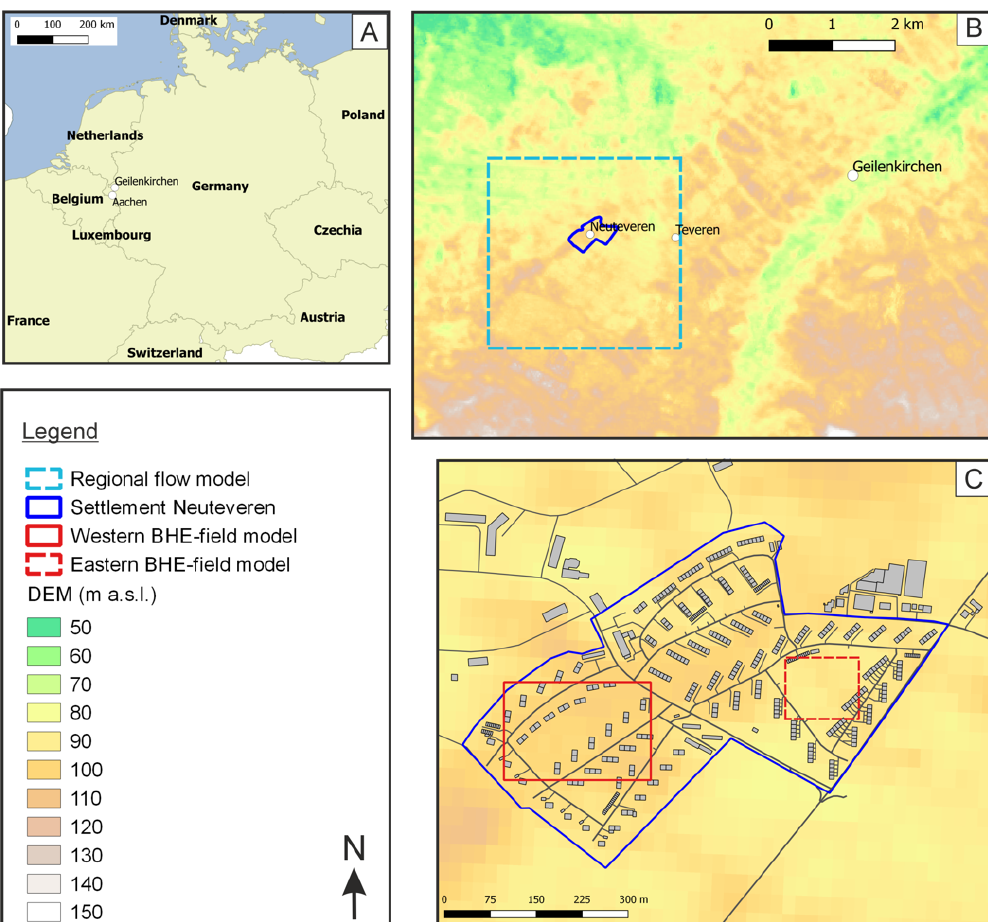
Figure 1. (a) Location of the study area in Germany. (b) Topography of the study area, its location relative to the city of Geilenkirchen and outline of regional flow model. (c) Layout of the settlement “Fliegerhorstsiedlung Teveren”, the grey boxes represent buildings. The digital elevation model seen in (b) and (c) was obtained from CGIAR (Jarvis et al., 2008).